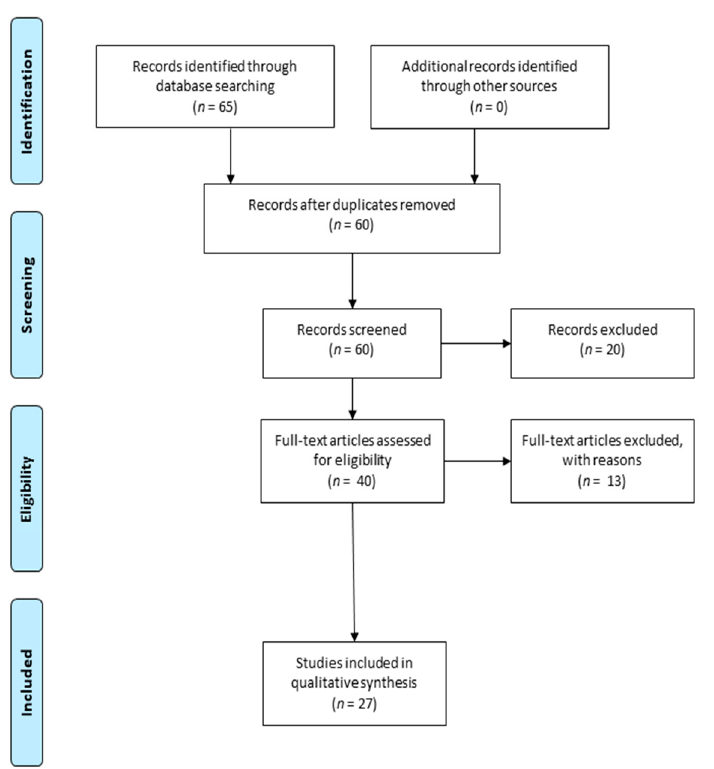
Figure 2. Prisma flow diagram illustrating the selection methodology of the preclinical studies used for the writing of the review. Duplicate articles were excluded from the total of the studies recorded. Instead, they were considered articles that evaluate the antioxidant effects of curcuminoid in neurological disease. The PRISMA Statement was published in [65].